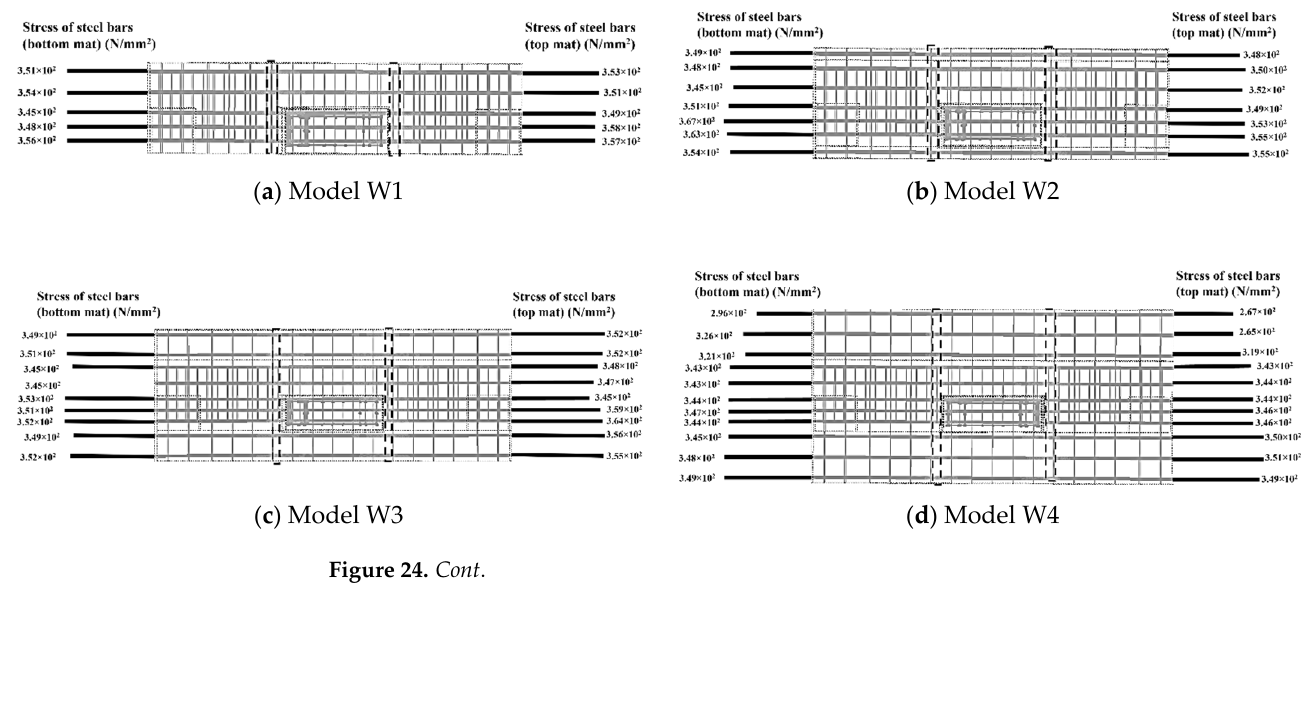
Figure 23. Lateral strength versus drift ratio curves for slab width models.